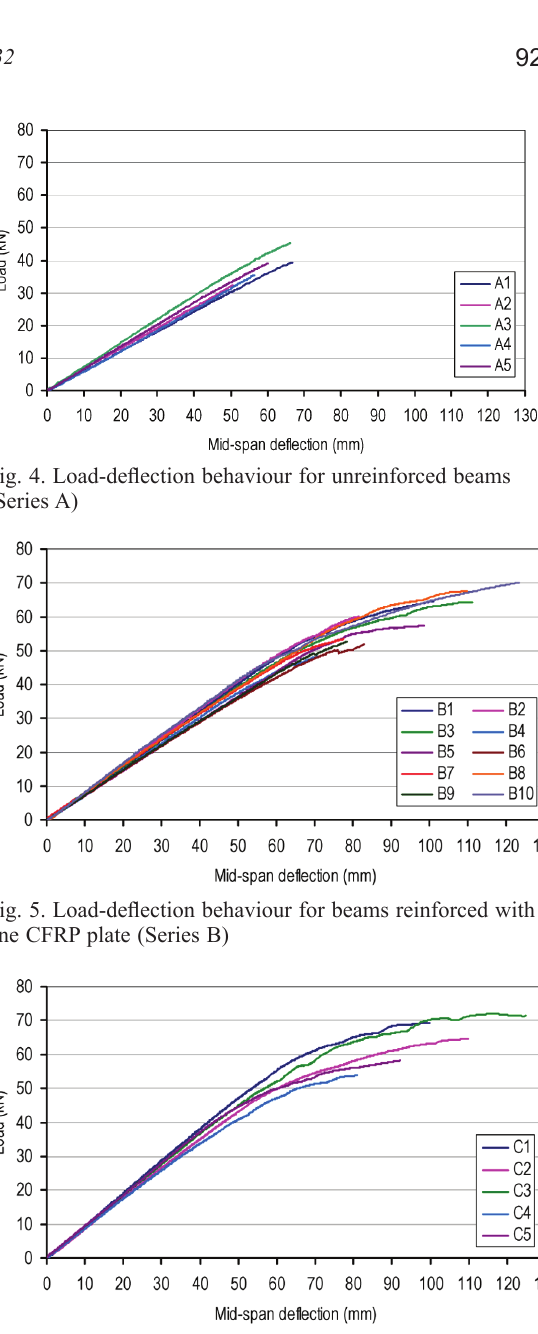
Fig. 6. Load-deflection behaviour for beams reinforced with two CFRP plates (Series